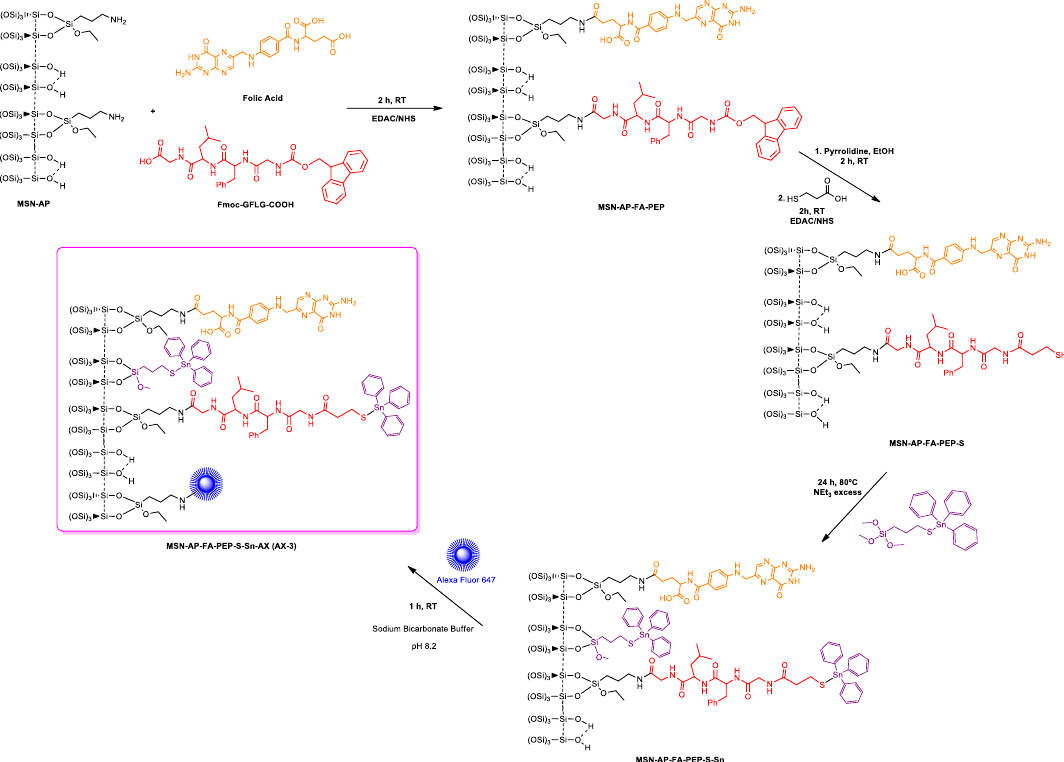
Scheme 3. Reactions of the formation of the tin-functionalized material AX-3.